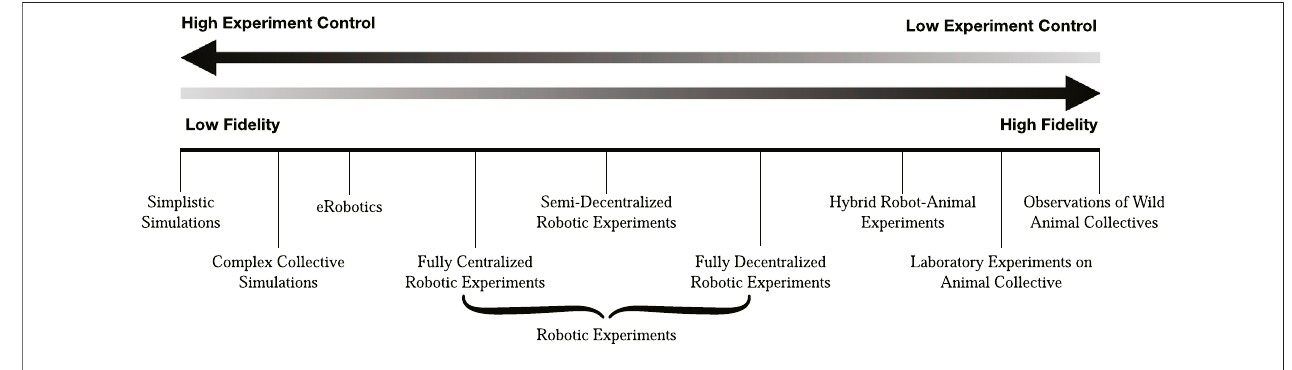
FIGURE1| Typesofcollectivebehaviorexperiments.Experimentswithmodelsandsimulationsprovidehighlevelsofexperimentalcontrolwhilecomingatthecost of reduced fi delity. Conversely, performing high fi delity experiments comes at the cost of lower levels of control.